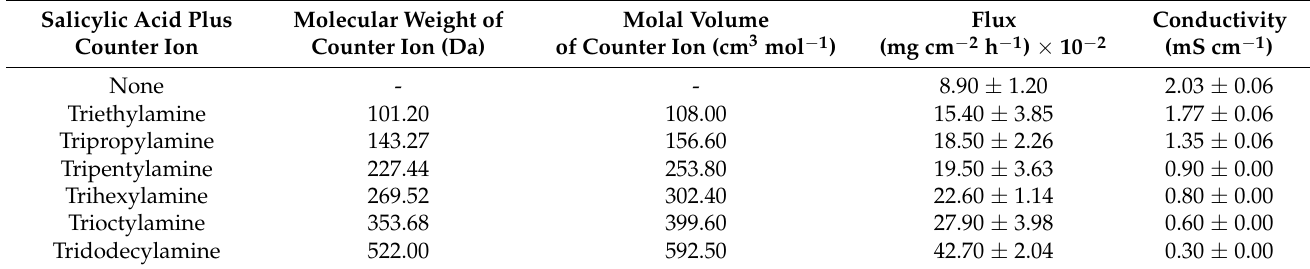
Table 7. Impact of tertiary amines on conductivity, on the permeation of SA through human epidermis, plus physicochemical properties of tertiary counter ions (for permeation experiments n ≥ 3 ≤ 6, values represent the mean ± S.E.M.) Adapted from [31], Wiley,